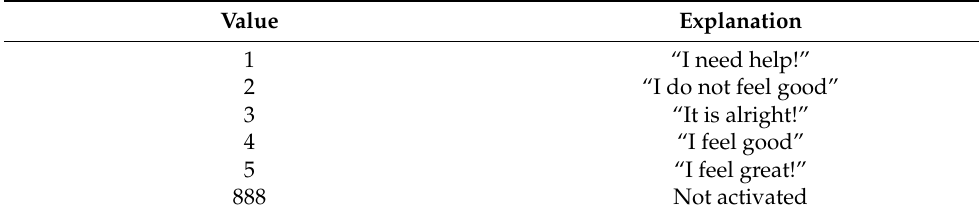
Table 2. Applied rating system for crowdsourcing/diagnosing the health state of the